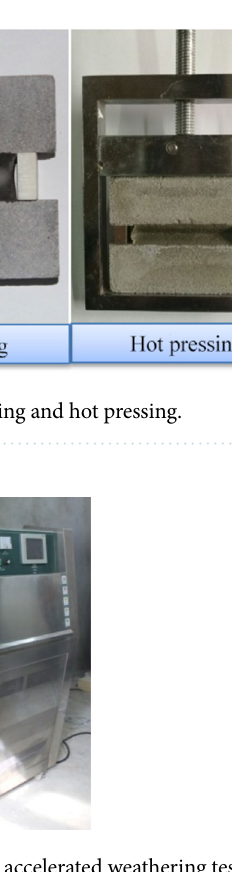
Figure 4. Ultraviolet accelerated weathering tester.